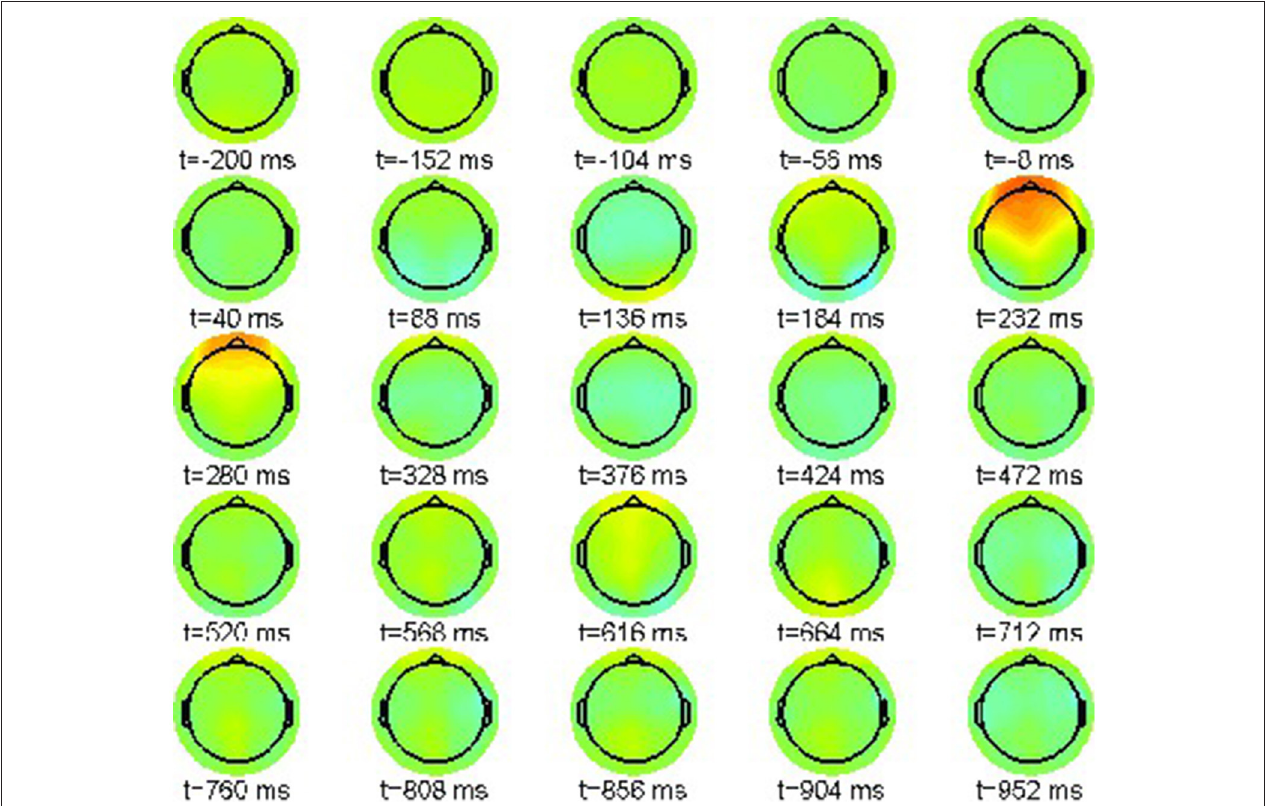
FIGURE 1 | Snapshot sequence of ERP scalp topographies for correct condition